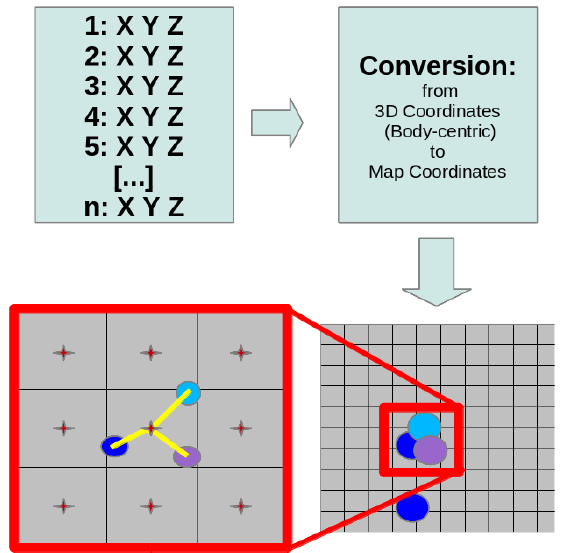
Figure 6: Interpolation Tool - The points with different colors represents the object points that fall into one pixel 3 TESTS